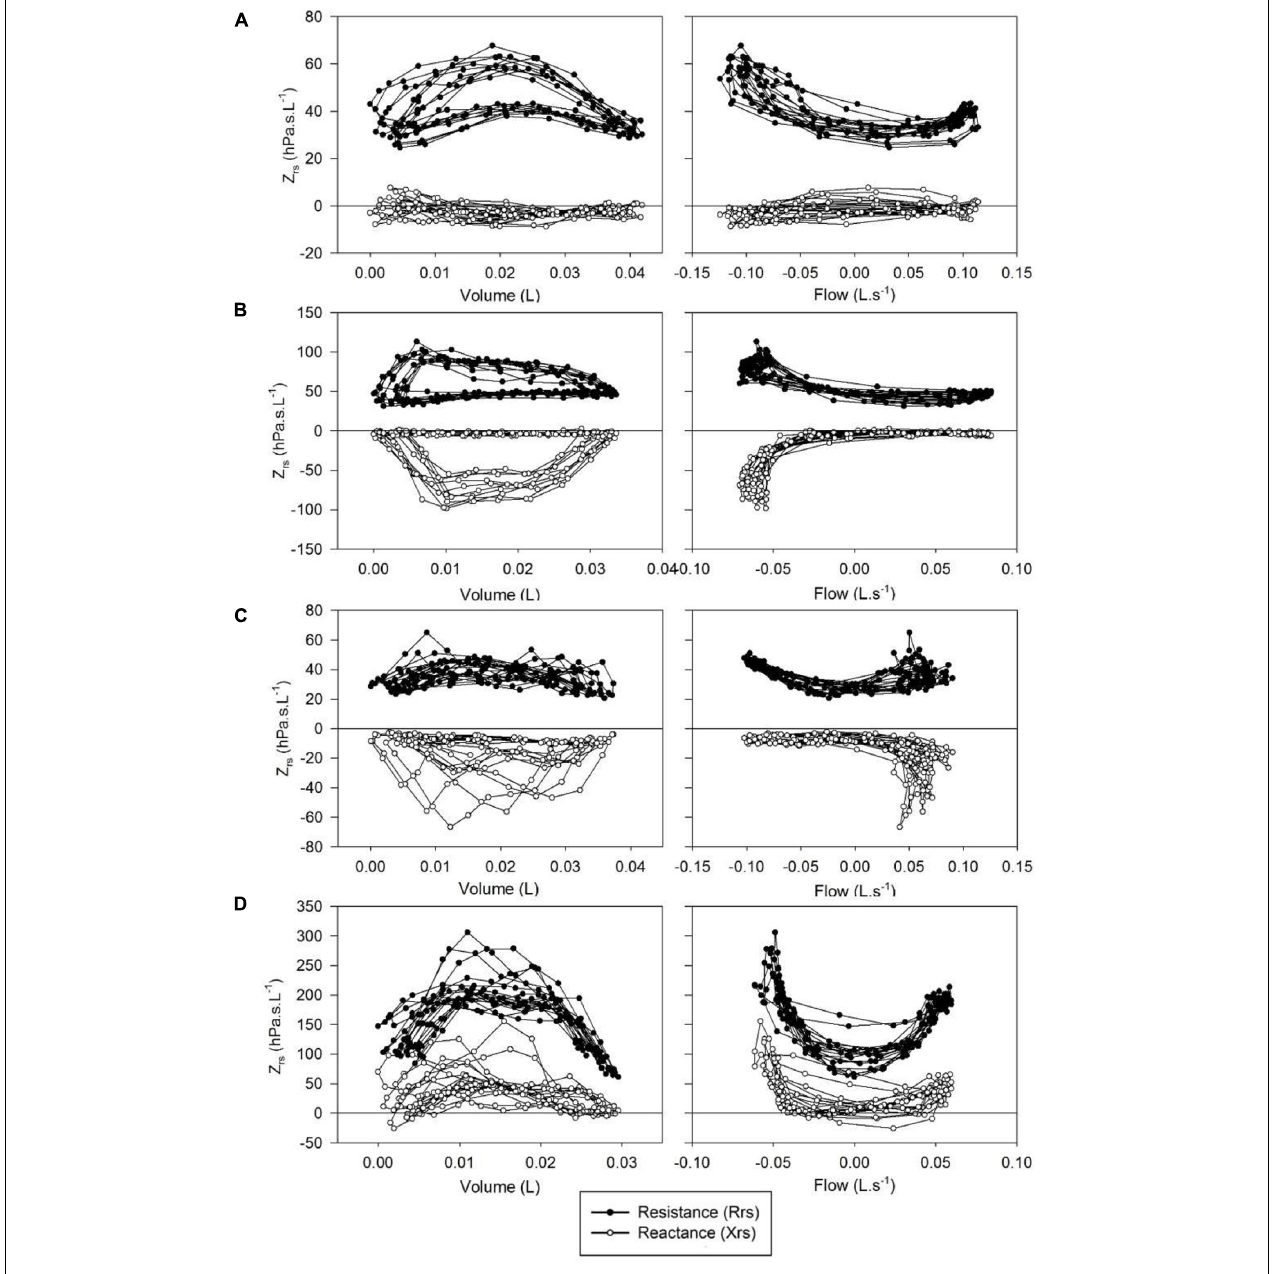
FIGURE 3 | Typical patterns of intrabreath changes in respiratory impedance (Zrs). (A) Insignificant changes in reactance (Xrs) and mild flow non-linearity in resistance (Rrs); (B) marked fall in Xrs and increase in Rrs during expiration; (C) marked fall in Xrs in inspiration; (D) increases in Xrs and Rrs with both inspiratory and expiratory